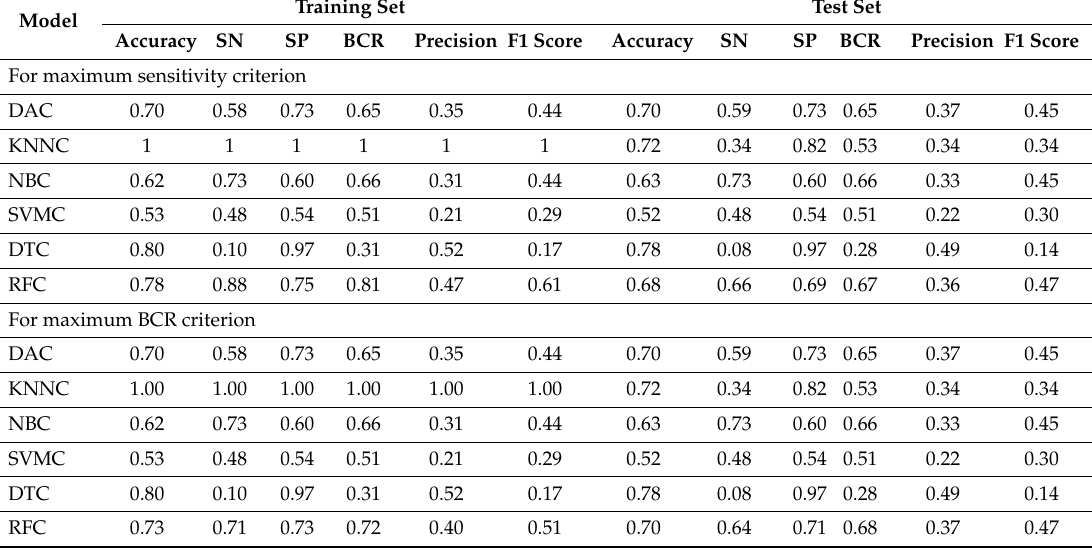
Table 4. Comparison of model performance for maximum sensitivity criterion and maximum BCR criterion.